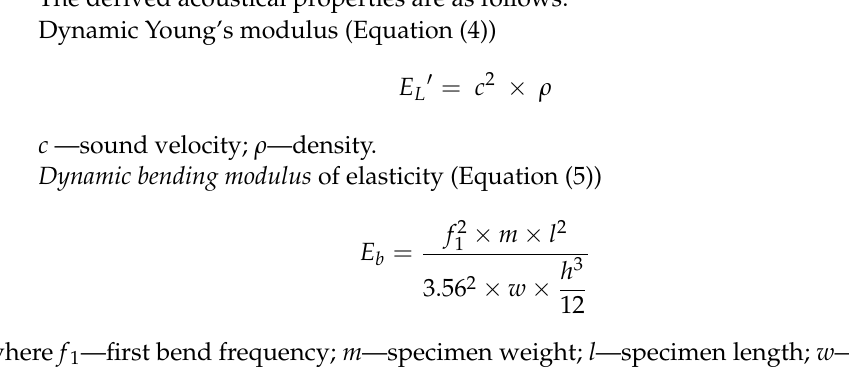
Figure 3. Measuring the acoustical properties: ( A ) soft hammer; ( B ) ultrasonic sensor or micro- phone; ( C ) specimen; ( D ) soft pads.